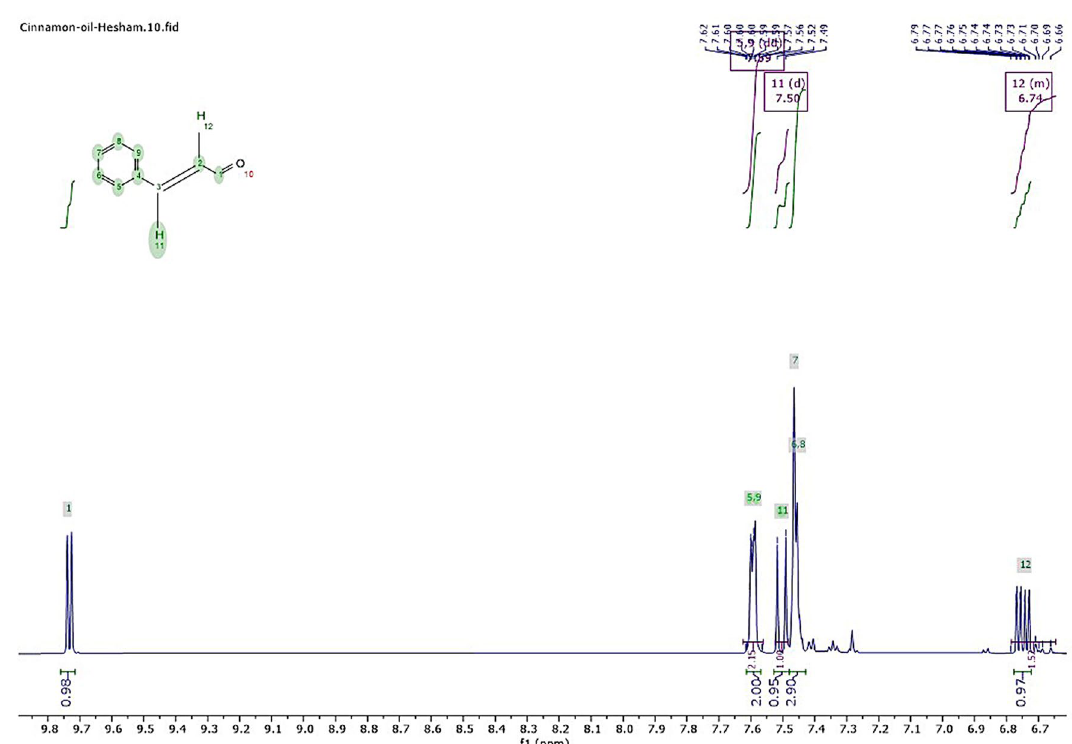
Figure 3. 1 H NMR spectrum of